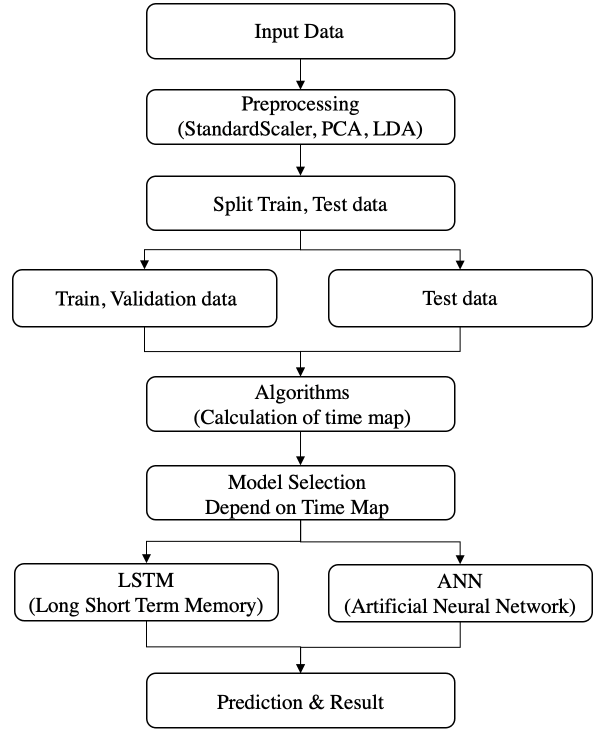
Figure 4. Structure and process of the PM 2.5 concentration prediction